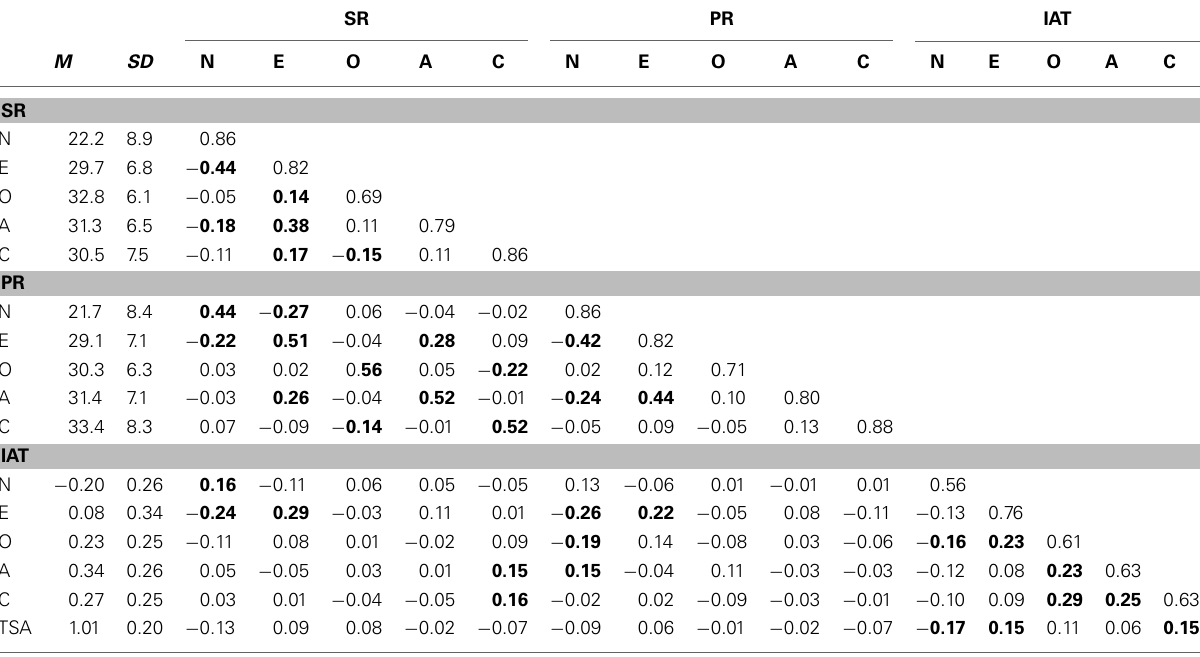
Table 1 | Means, standard deviations, reliabilities, and intercorrelations of all measures. SR PR